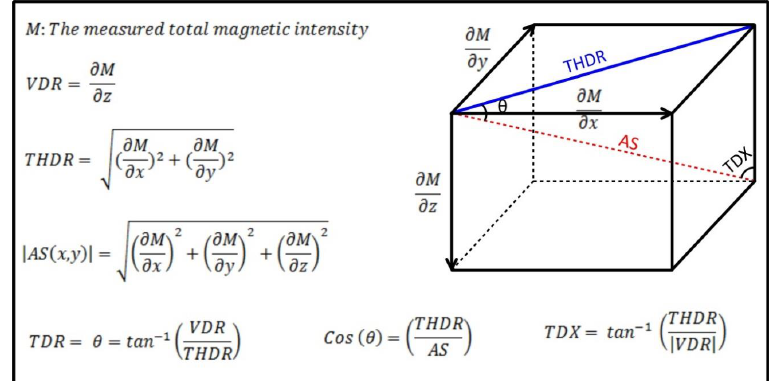
Figure 1. Definition of the geometrical relationships between first-order vertical derivative (VDR), total horizontal derivative (THDR), analytic signal (AS), tilt angle (TDR), Theta map (Cos ( θ )), and horizontal tilt angle (TDX).